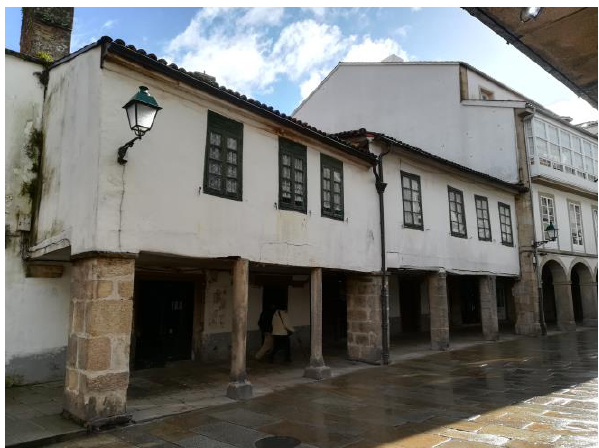
Figure 11. Houses with arcades in the Rúa Nova in Santiago de Compostela. One of the few preserved examples of housing typology with arcades and half-timbered structure with small holes. Source: